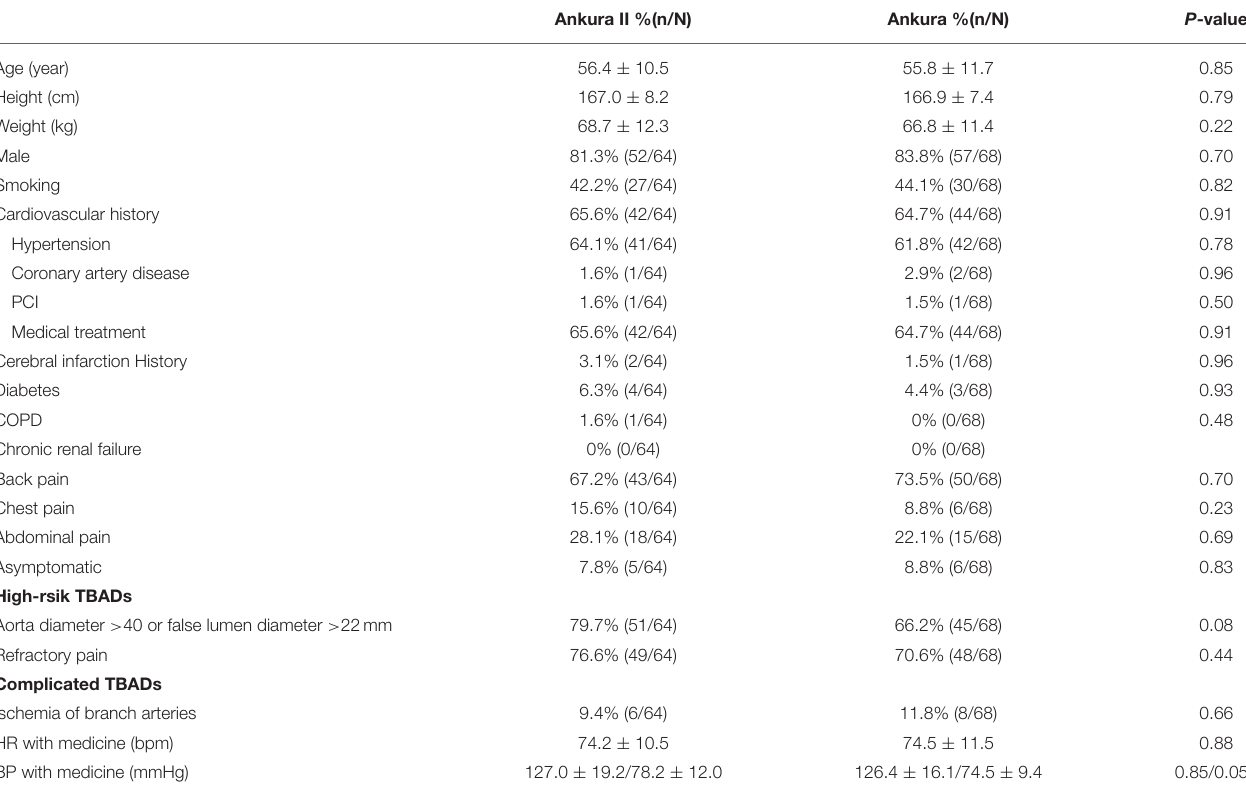
TABLE 2 | Demographics of the enrolled